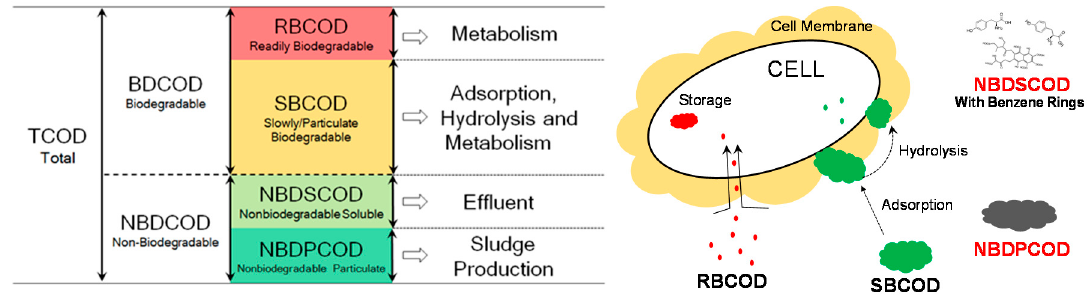
Figure 1. Schematic diagram of the chemical oxygen demand (COD) fractions and their fates in a biological wastewater treatment plant.